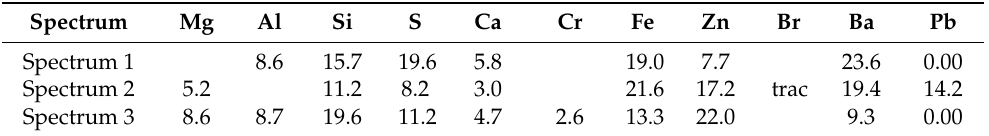
Table 4. Elements detected through EDS analysis of the areas shown in Figure 6b. Results are reported in weight percentage (w%) removing the counts of oxygen and